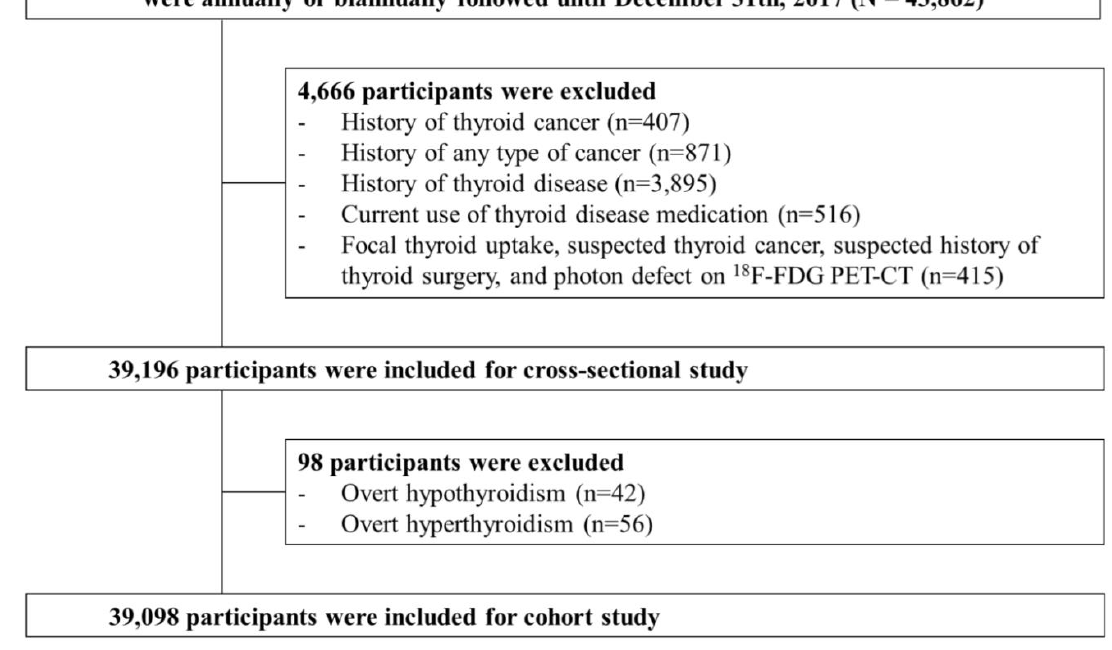
Figure 1. Diagram for selection process of study Figure1. Diagram for selection process of study participants.